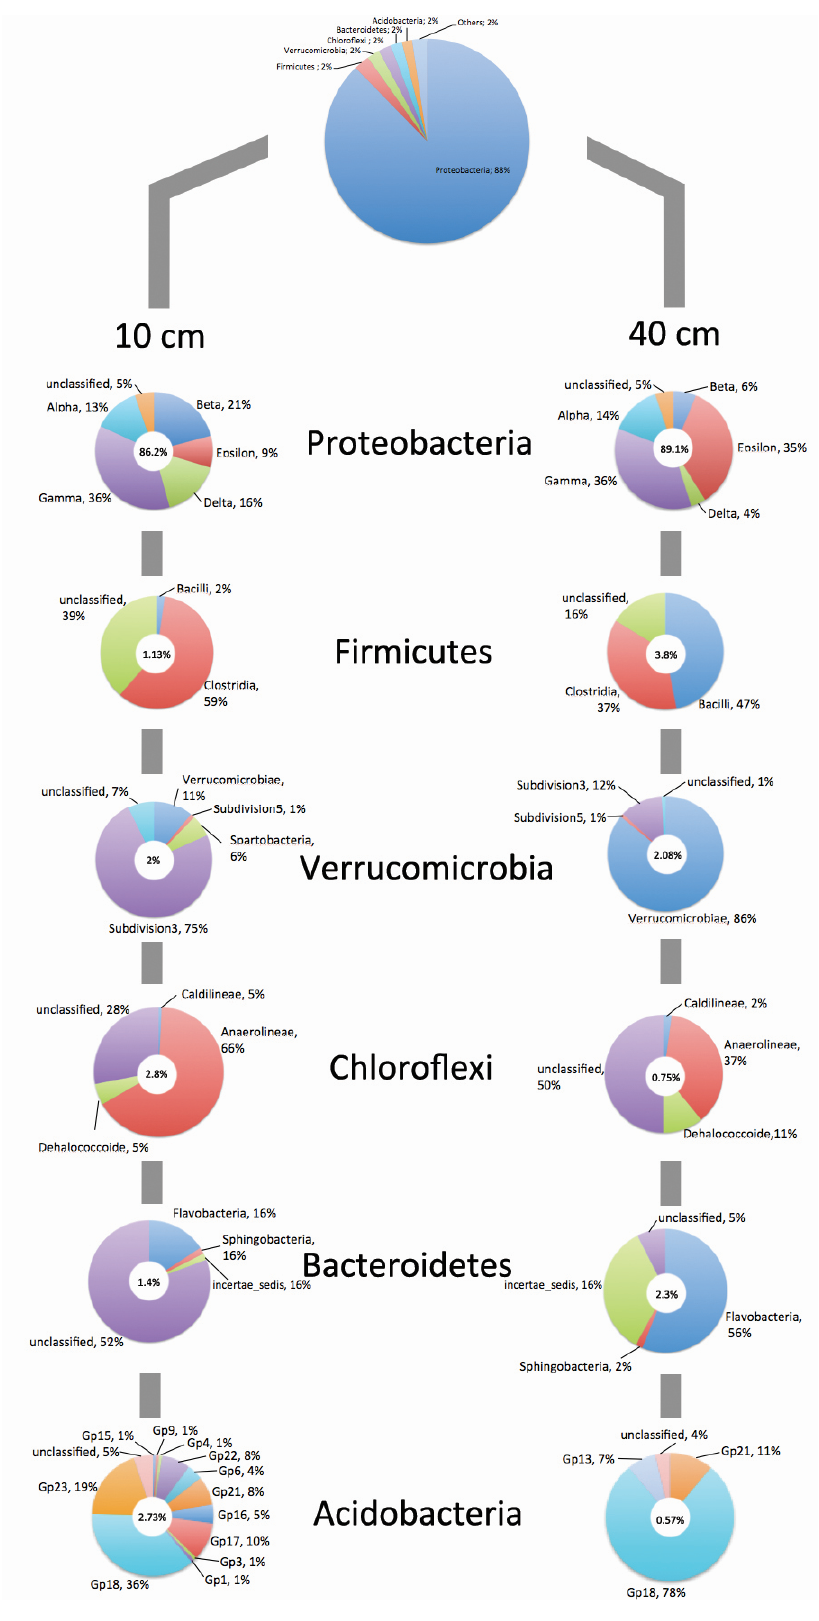
Figure 5. Bacterial composition distribution of partial 16S rRNA sequences from mangrove sediments at 10 and 40 cm depths. The sequences were classified using RDP Ribosomal Database Project classifier at phylum and class levels. The percentage inside circles refers to the relative abundance of each phylum at each